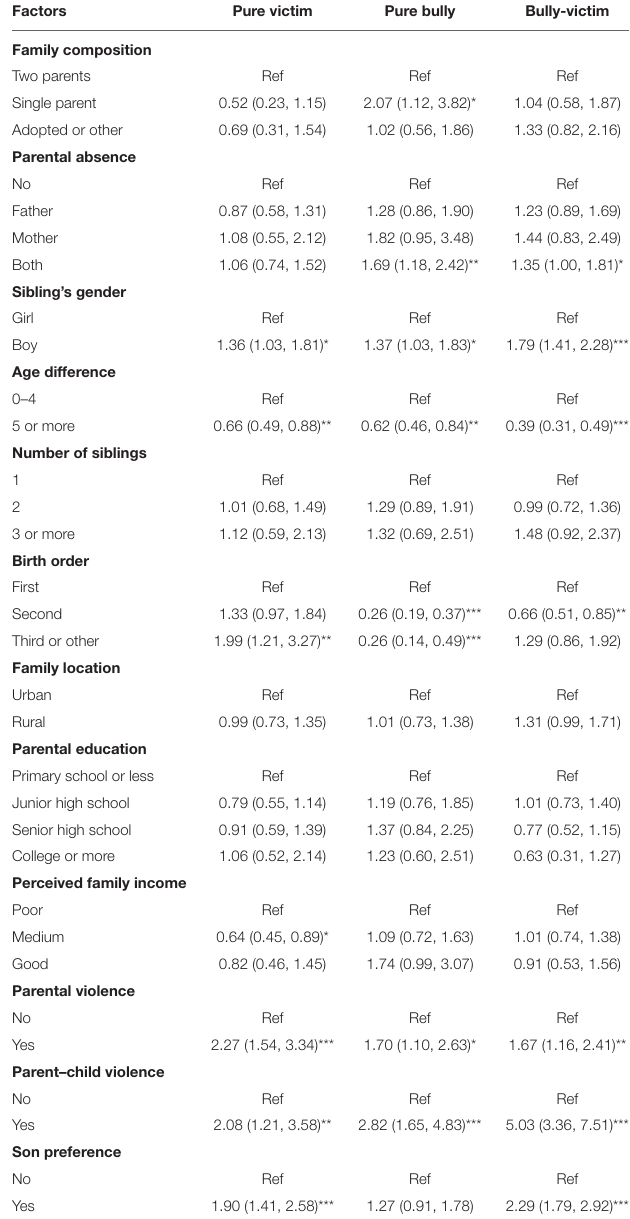
TABLE 2 | Prevalence and percent of roles of sibling bullying by gender. TABLE 3 | Multinomial logistic regression of roles of sibling bullying among boys ( N = 2846).